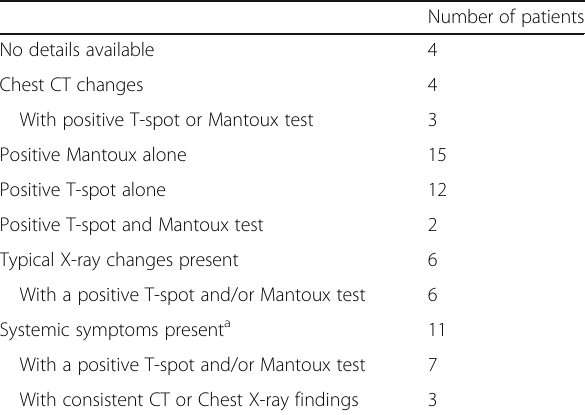
Table 2 Investigations to support TB